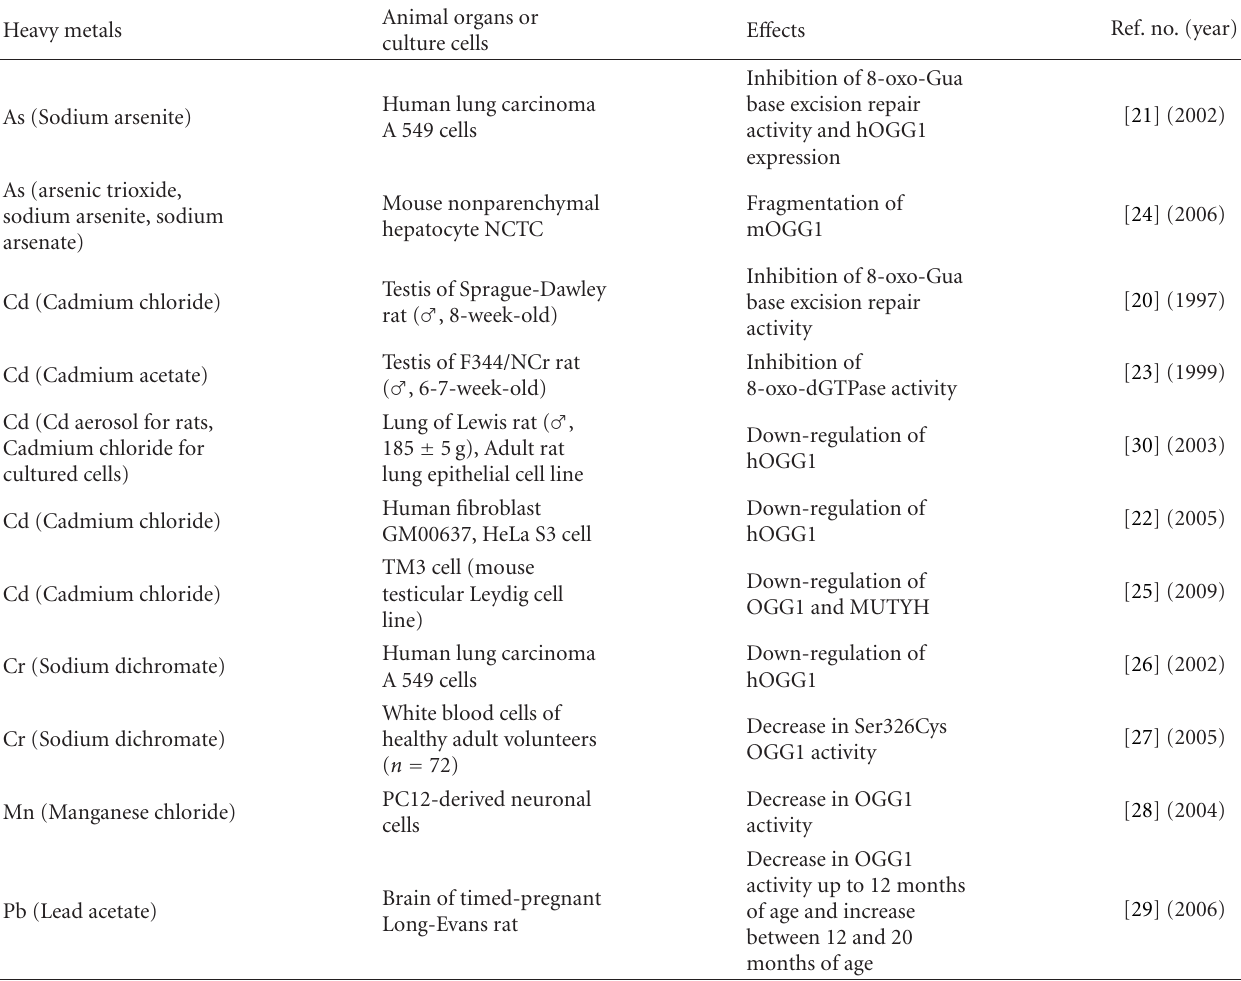
Figure 1: Structure of 8-oxo-Gua. 8-Oxo-Gua is formed by the hydroxylation of guanine at the C-8 position. Table 1: Association of heavy metal exposure with 8-oxo-Gua